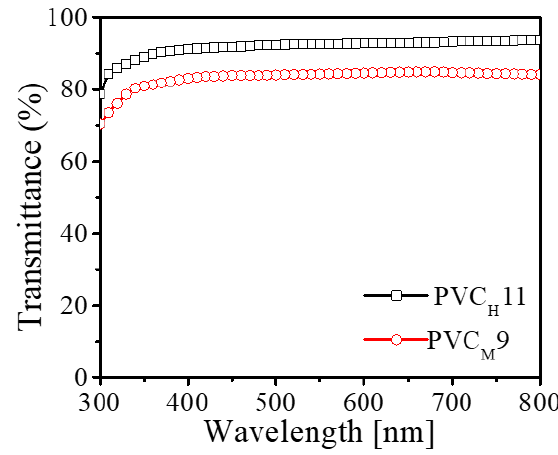
Figure 11. Bending angles of three PVC gels: PVC L 5, PVC M 9 and PVC H 11.